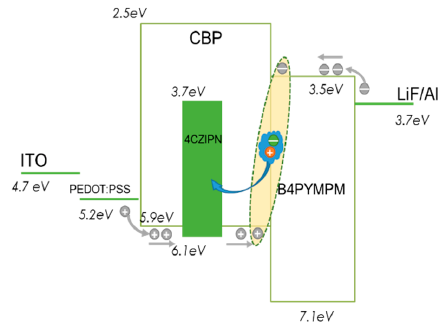
Figure 2. Device structure and energy diagram of organic light emitting devices (OLEDs). B4PyMPM: